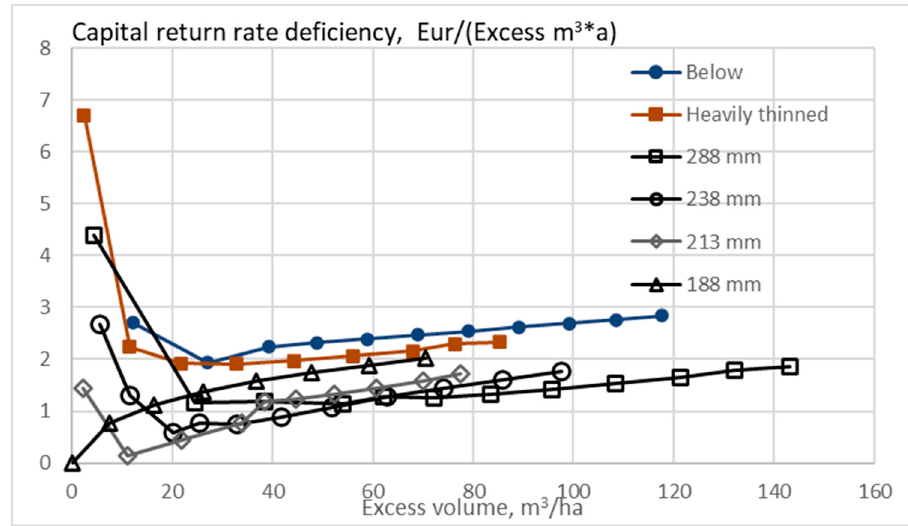
Figure 14. The deficiency of the expected value of capital return rate in terms of Euros per excess volume and year. The deficiency is plotted for six different treatment schedules as a function of excess volume. Negative values are omitted from the Figure.